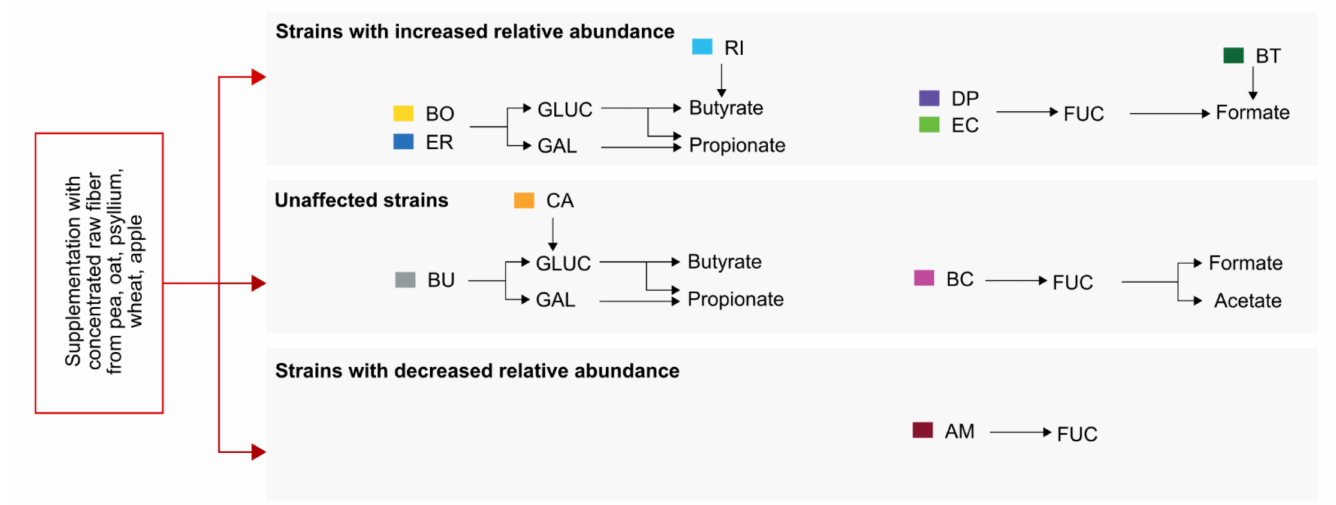
Figure 6. Summary of correlations between relative abundances of 14SM strains, glycan-degrading enzyme activity and SCFA production in response to fiber supplementation. Strains that are significantly increased in FS-fed mice compared to FF-fed mice are depicted in the upper panel, while unaffected strains are shown in the middle panel and strains with decreased relative abundance in the lower panel. Arrows only show significant ( p < 0.05) positive (0 < R < 1) correlations as determined in Figures 3–5. AM: A. muciniphila , BC: B. caccae , BO: B. ovatus , BT: B. thetaiotaomicron , BU: B. uniformis,